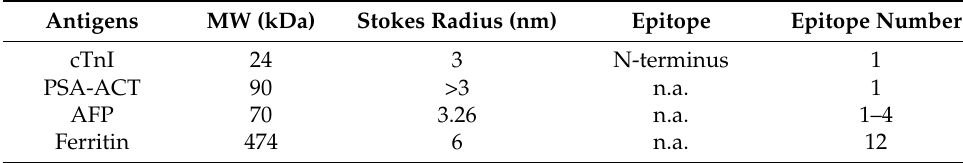
Table 1. Properties of the antigens used in the